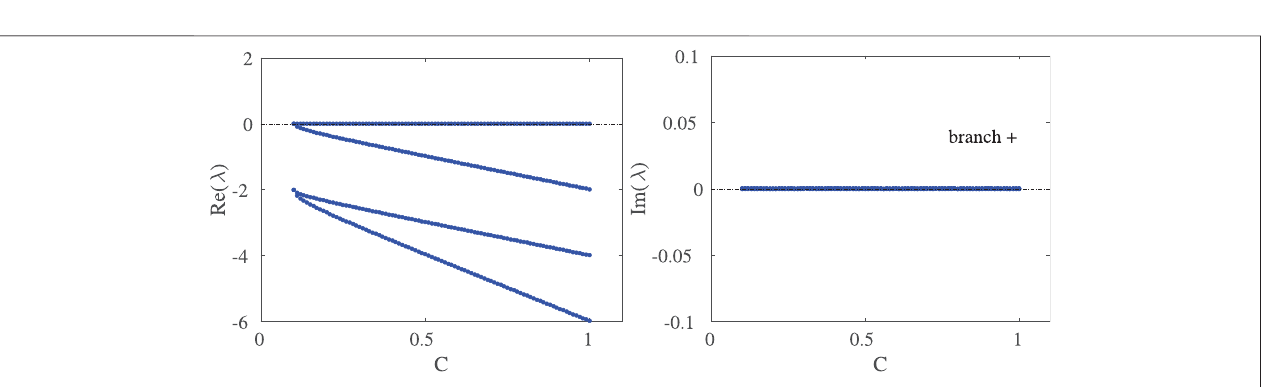
FIGURE 2 | Dependence of the real and imaginary parts of the eigenvalues of steady state symmetric solutions from the upper (+) branch. The other parameter values remain as in the caption of Figure 1 .